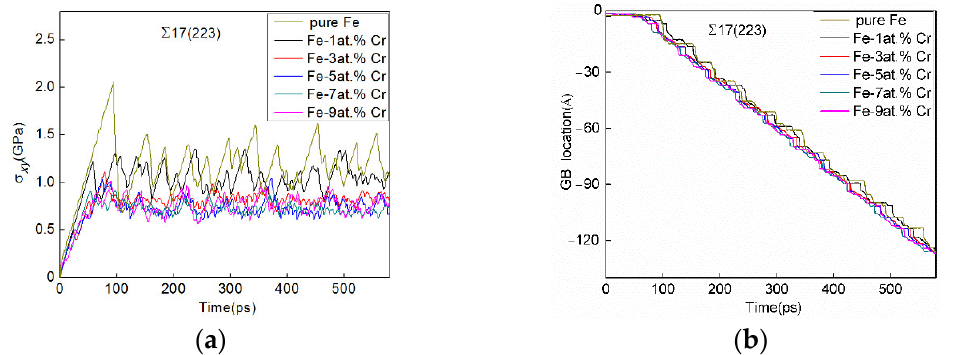
Figure 3. Shear process of the Σ 17(223) GBs in pure Fe and Fe-X at.% Cr alloys (X = 1, 3, 5, 7, and 9).